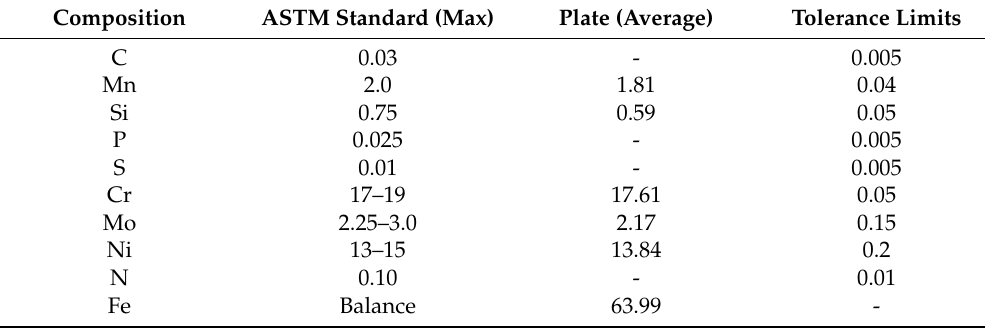
Table 1. X-Ray energy dispersive spectroscopy (EDS) measured composition for plate (wt %). Composition ASTM Standard (Max) Plate (Average) Tolerance Limits